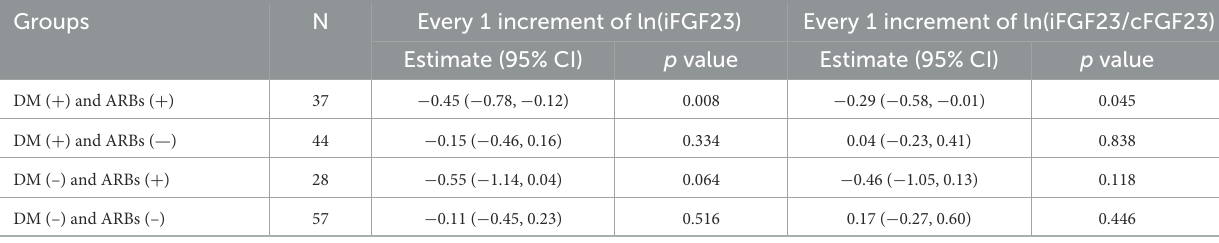
TABLE 4 The association of FGF23 and hemoglobin in the groups of DM and ARBs. Groups